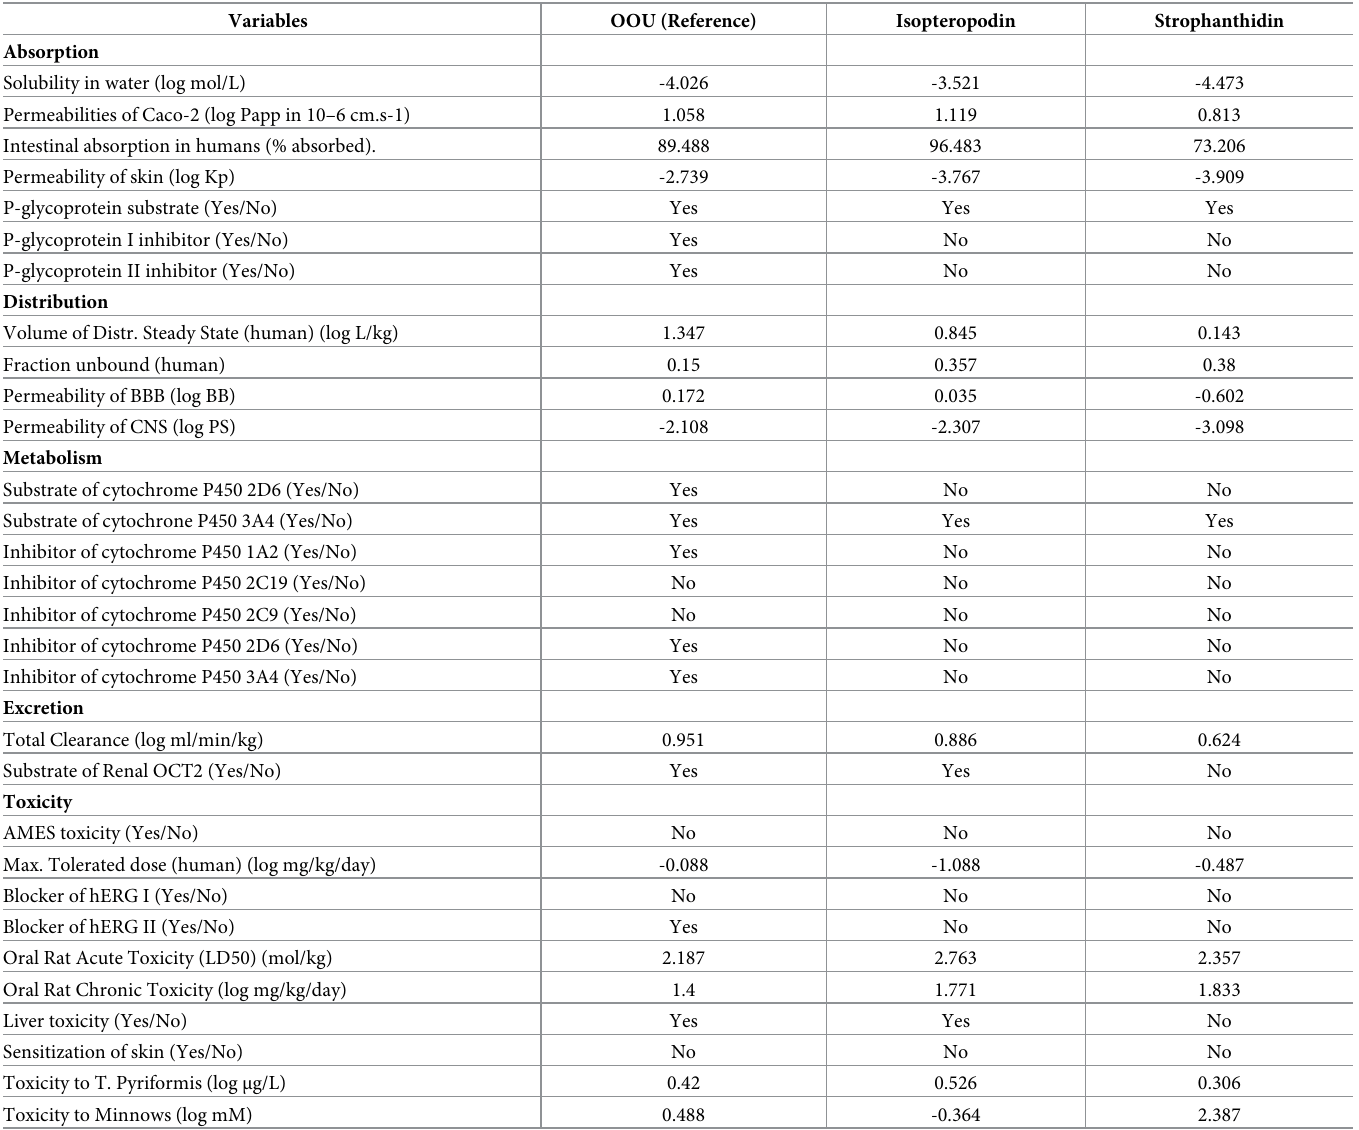
Table 2. ADMET properties of reference and lead compounds.